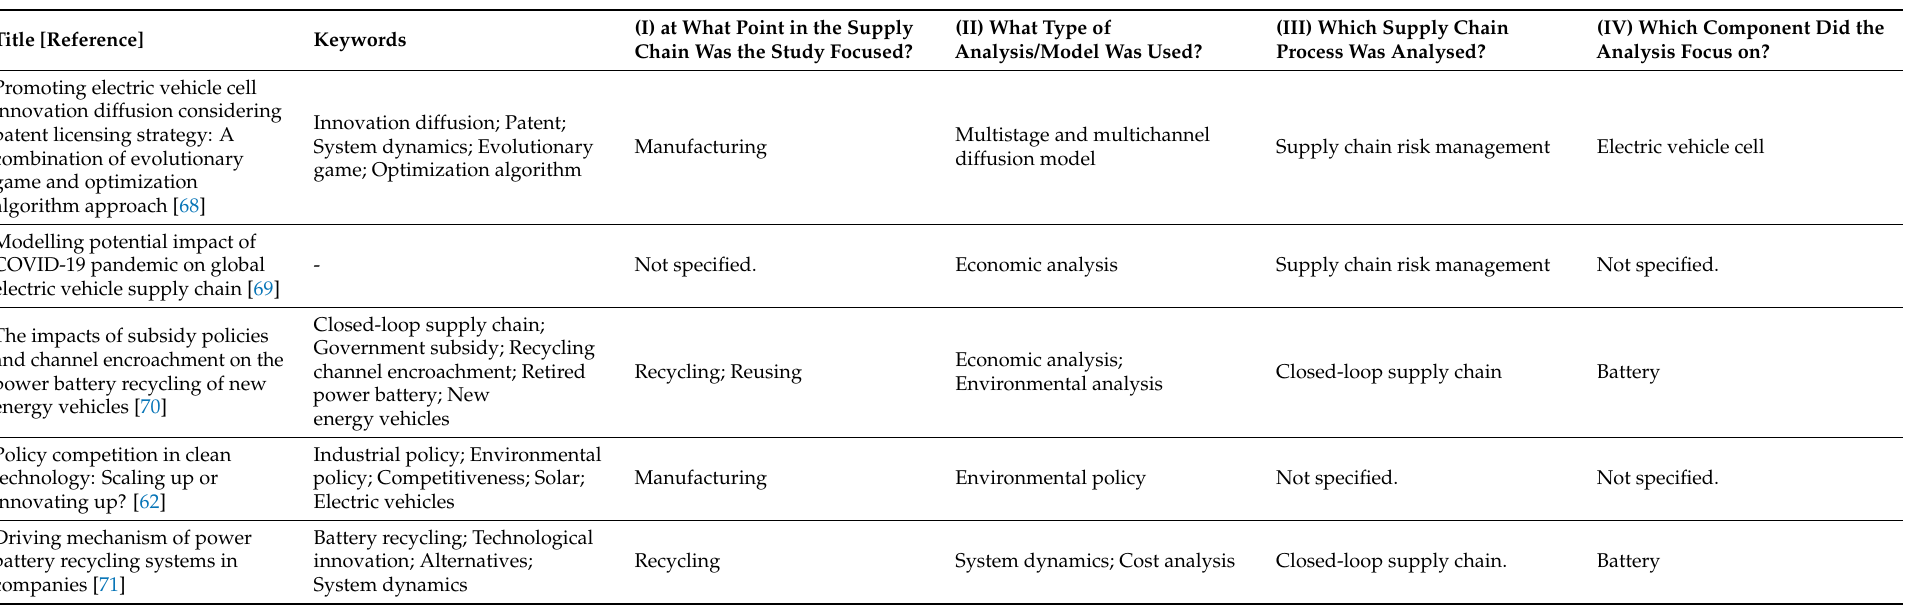
Table A8. PRISMA meta-analysis of documents found related to electric vehicles supply chains.